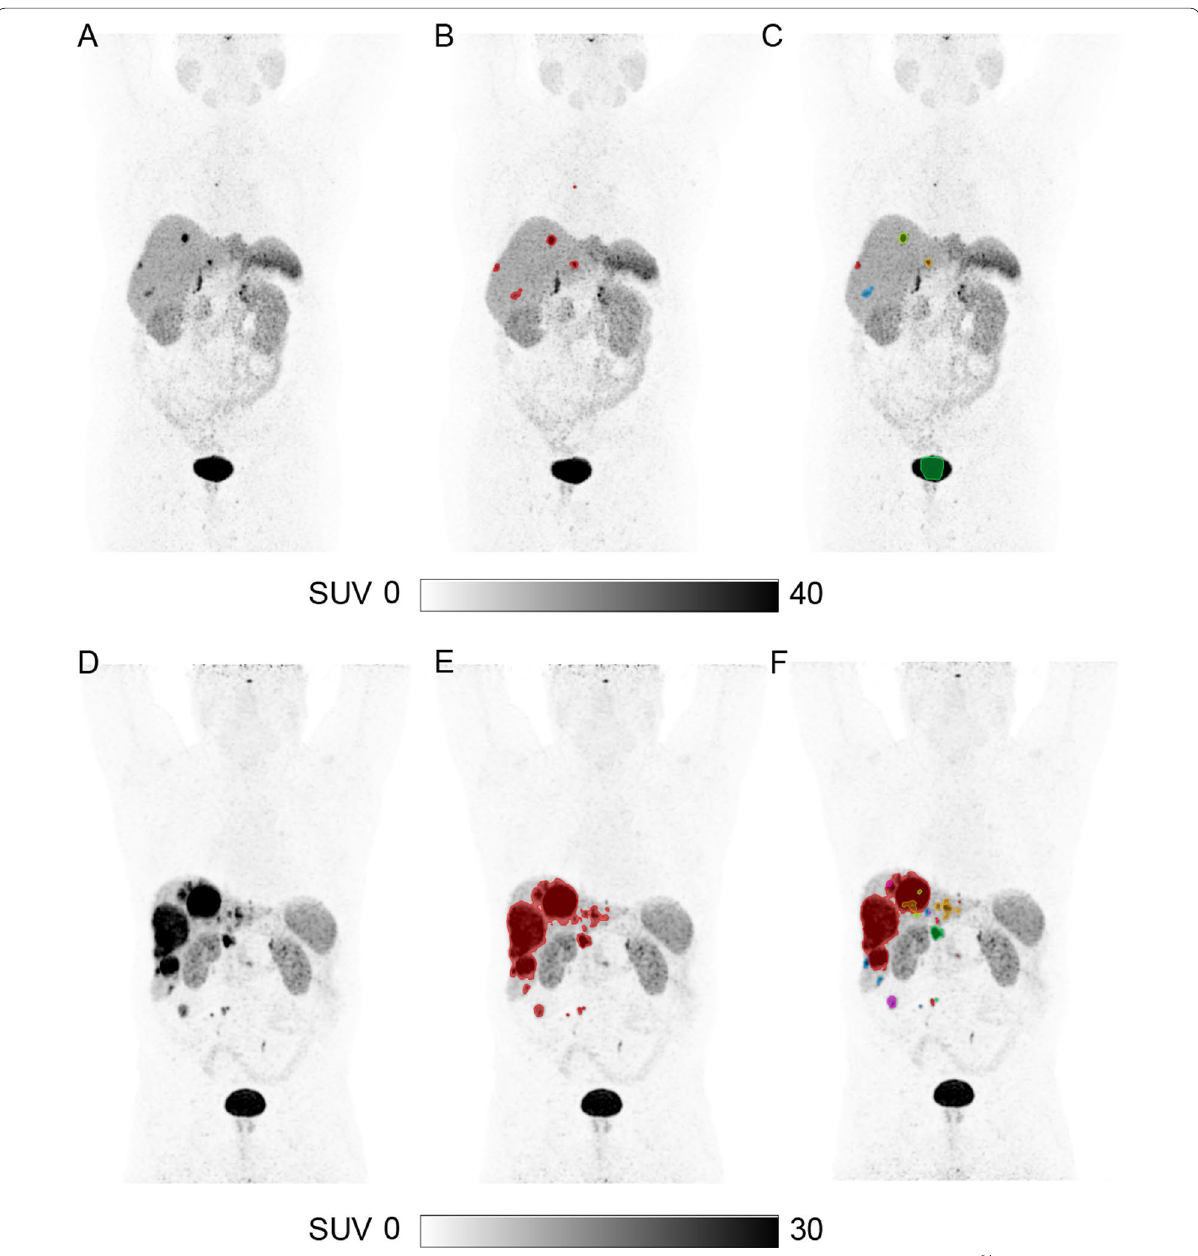
Fig. 3 Representative examples of the segmentations from the AI model for two patients. Maximum intensity projection [ 64 Cu]Cu-DOTATATE PET without tumor segmentation ( A , D ). Ground truth segmentation of tumor ( B , E ). AI predicted segmentations—no manual adjustments performed ( C , F ). In the AI output, all separate segmentations are given a unique color, e.g., red, blue, green, making manual adjustment with deletion of a segmentation easy and fast (e.g., part of the bladder was erroneously segmented in C